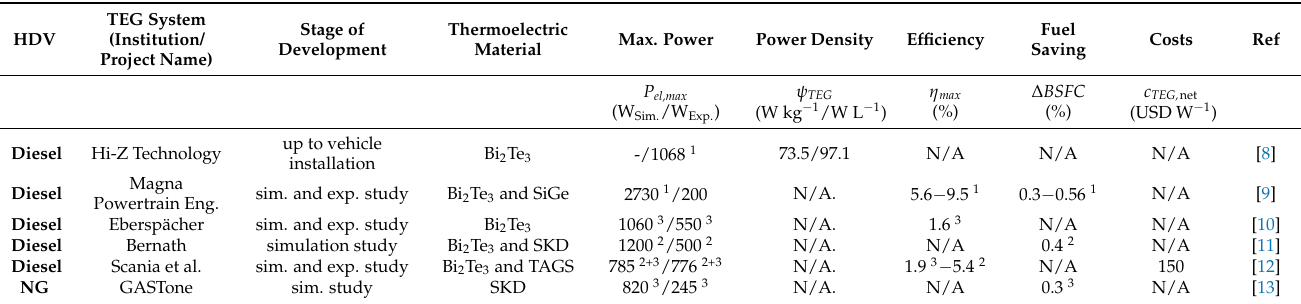
Table 1. State of the art for TEG systems in commercial vehicles reported in the literature (chronologi- cally ordered); data based on